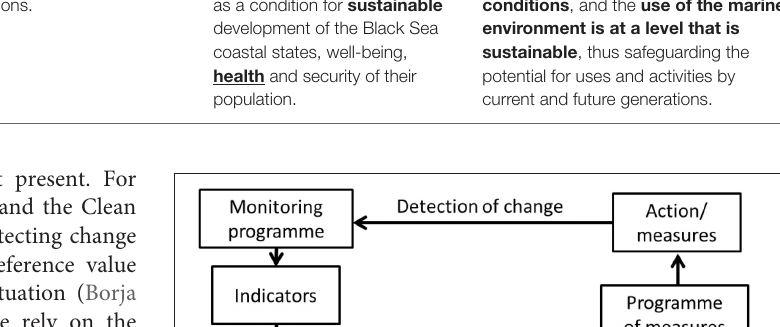
TABLE 3 | Comparison of the visions of the Good Environmental Status (GES) characterized by the regional sea conventions, OSPAR (The Convention for the Protection of the Marine Environment in the North-East Atlantic), HELCOM (The Convention on the Protection of the Marine Environment in the Baltic Sea Area—the Helsinki Convention), UNEP/MAP (The Convention for the Protection of Marine Environment and the Coastal Region of the Mediterranean—the Barcelona Convention, implemented in the framework of UNEP/MAP), BSC (The Convention for the Protection of the Black Sea—the Bucharest Convention, implemented by the Black Sea Commission), and the Marine Strategy Framework Directive (MSFD). OSPAR HELCOM UNEP/MAP BSC MSFD N.E. Atlantic Baltic Sea Mediterranean Black Sea All regional seas Clean , healthy and biologically diverse North-East Atlantic ocean,